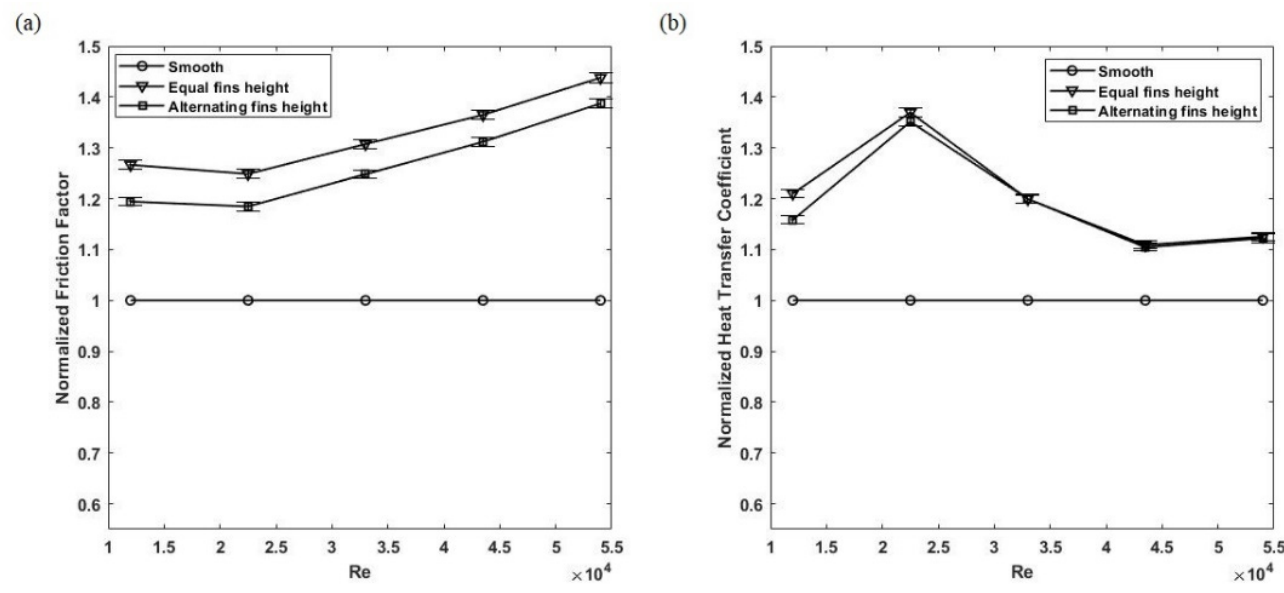
Figure 12. ( a ) Friction factor and ( b ) Heat transfer coefficient, normalized with respect to smooth tube.